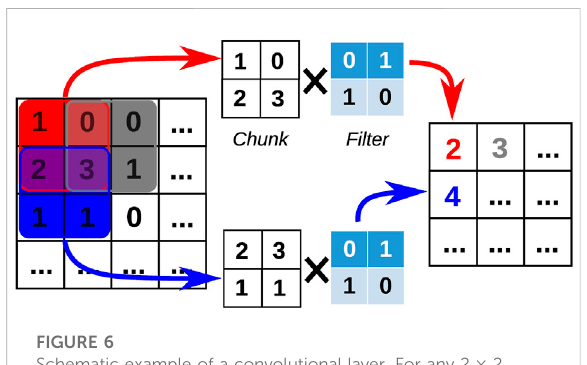
FIGURE 6 Schematic example of a convolutional layer. For any 2 × 2 chunk C of the input image on the left, this convolutional layer performs the point-wise multiplication of C with the fi lter F followed by the addition of all elements. This compresses the initial chunk of the image into a single